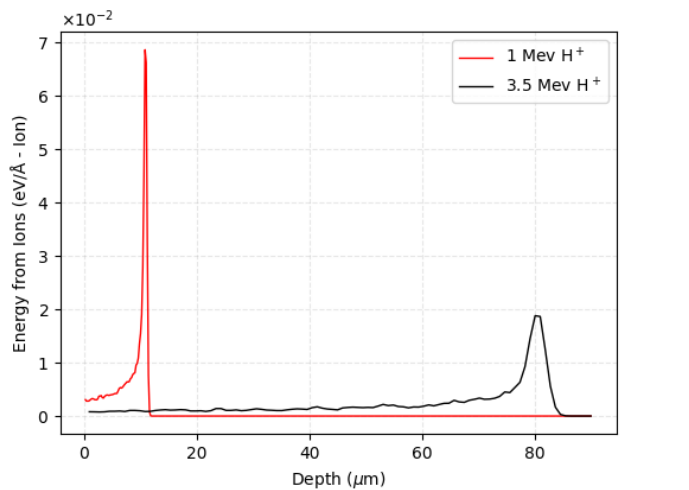
Figure 3. Energy loss as a function of depth in silicon carbide for a 1 MeV (in red) and 3.5 MeV (in black) protons beam produced by the SRIM simulation